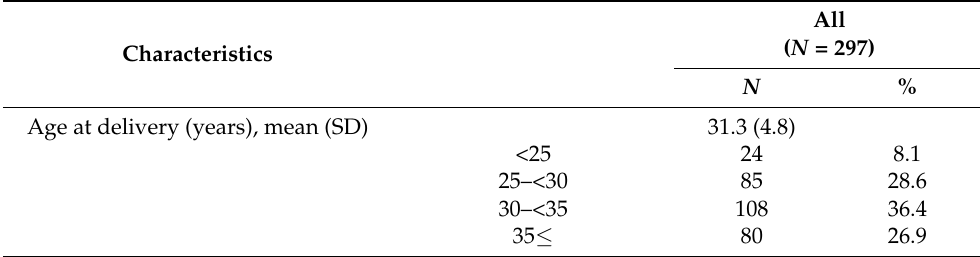
Table 1. The characteristics of the mothers included in this study.